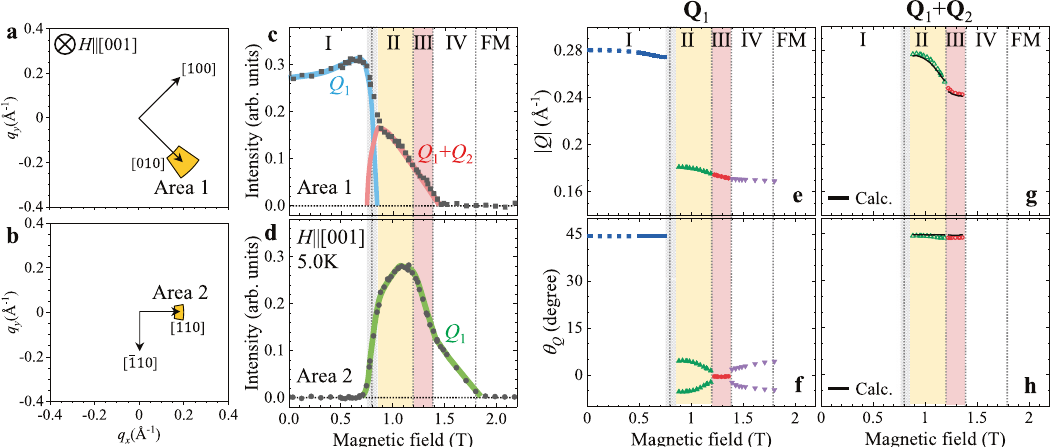
Fig. 3 Magnetic- fi eld dependence of the magnetic modulation vectors in EuAl 4 . a , b Schematic illustrations of Area 1 and Area 2 used for the SANS intensity integration. c , d The SANS integrated intensities for Area 1 ( a ) and Area 2 ( b ) as a function of magnetic fi eld for H || [001] at 5.0 K. The colored lines in ( c , d ) are guides to the eye, showing the assignment of each magnetic re fl ection to either Q 1 or Q 1 + Q 2 . e , f Magnetic- fi eld dependence of the wavenumber | Q | ( e ) and azimuth angle θ Q ( f ) of the fundamental magnetic modulation vector Q 1 . Here, θ Q is de fi ned as the angle between the Q -direction and the [110] axis, as shown in Fig. 2a. g , h The corresponding data for the higher-order Q 1 + Q 2 magnetic satellite re fl ection. The black curves in ( g , h ) represent the theoretical | Q | and θ Q values for Q 1 + Q 2 re fl ection calculated from fundamental magnetic re fl ections in ( e , f ), which agree well with the experimental data. The gray regions between phases I and II indicate the phase coexistence region (see Supplementary Note to Eq. (1). In Fig. 4c, the temperature dependence of I SF and I NSF ( s z Q ) represents the modulated spin component normal to both i measured at 1 T is summarized. In phase IV above 11 K, the magnetic modulation vector Q i and the [001] axis (parallel to the magnetic scattering appears only in the I SF channel but not in the [001] axis). The resultant spin textures for phases II and III are I NSF channel. It suggests that ^ m ð Q Þ in phase IV consists only of illustrated in Fig. 2f, g, which can be considered as the rhombic the in-plane component normal to Q . A similar conclusion is also and square lattice of magnetic skyrmions, respectively, according